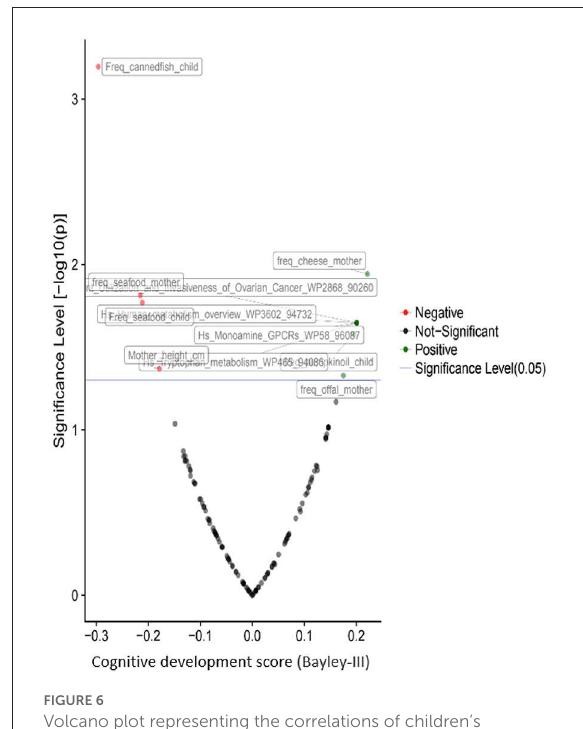
FIGURE6 Volcano plot representing the correlations of children’s cognitive development with prenatal and postnatal exposure factors during the first year of life based on the results from the PHIME cohort. The pathways resulted from the untargeted urinary metabolomics analysis. Cognitive development of children is positively associated with the metabolism of tryptophan indicating that the imbalance between the cellular reactive oxygen species (ROS), which may be an effect of exposure to metals, and the impossibility for the cell to detoxify them, leads to oxidative stress.